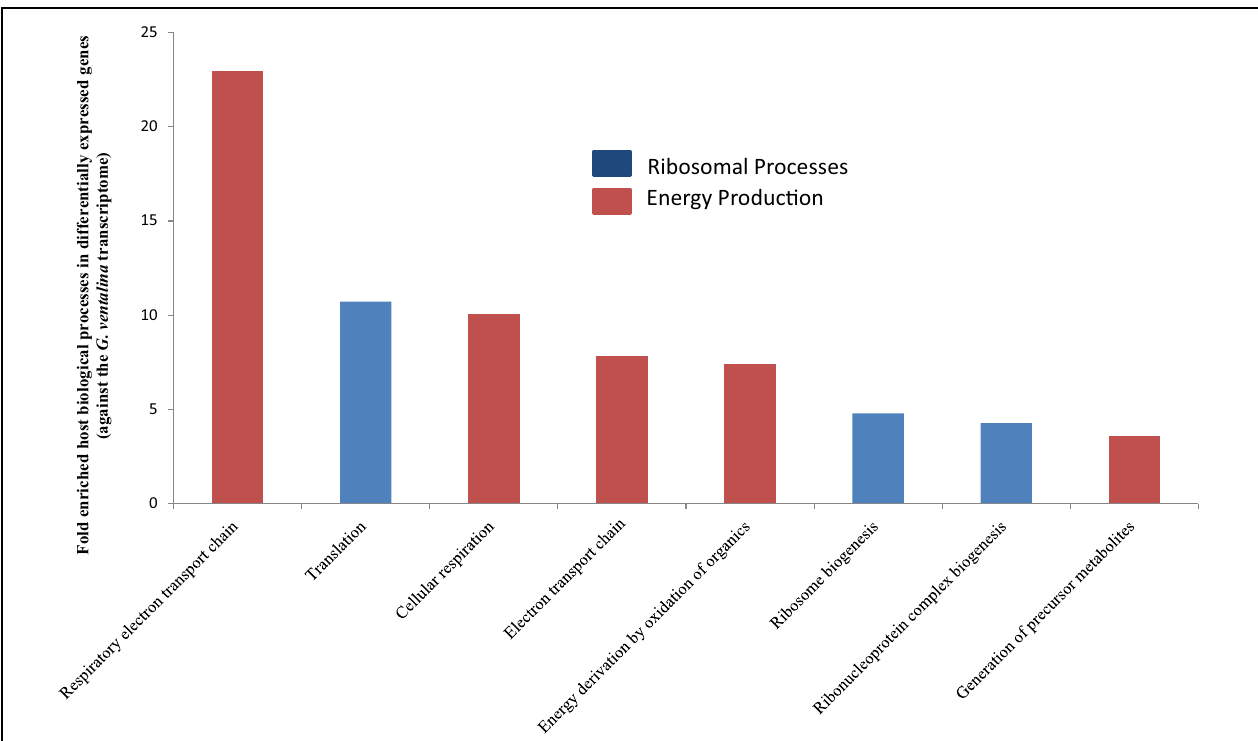
FIGURE 3 | Gene Ontology (GO) terms for biological processes that were significantly overrepresented in differentially expressed G. ventalina genes upon Aplanochytrium exposure as determined via enrichment analysis using DAVID (Huang et al., 2009a,b) ( p < 0 .